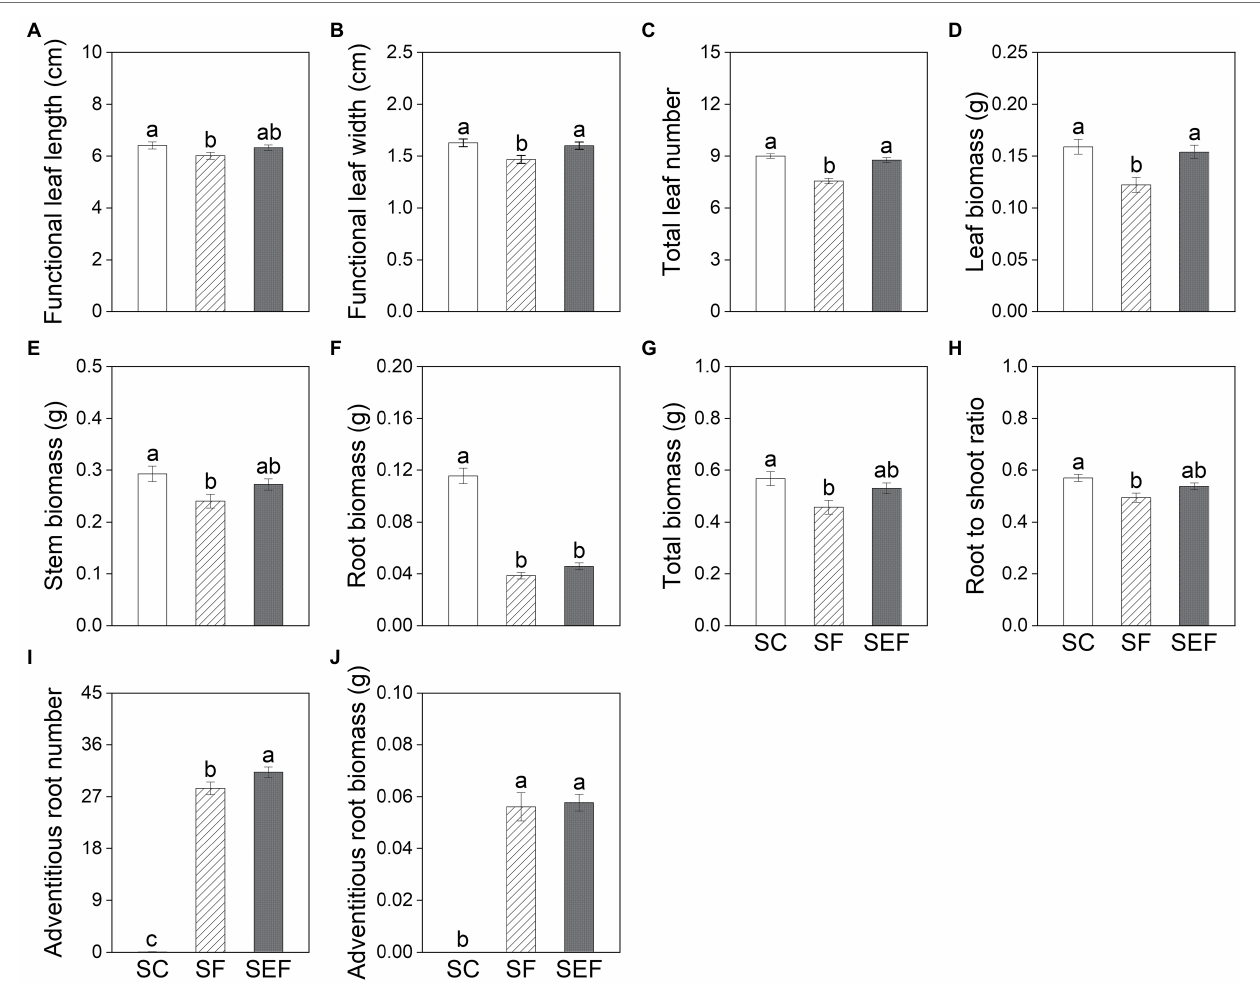
FIGURE 4 | Functional leaf length (A) and width (B) , total leaf number (C) , leaf biomass (D) , stem biomass (E) , root biomass (F) , total biomass (G) , root to shoot ratio (H) , adventitious root number (I) and biomass (J) of P. hydropiper subjected to subsequent treatments of control (SC), flooding (SF), and eutrophic